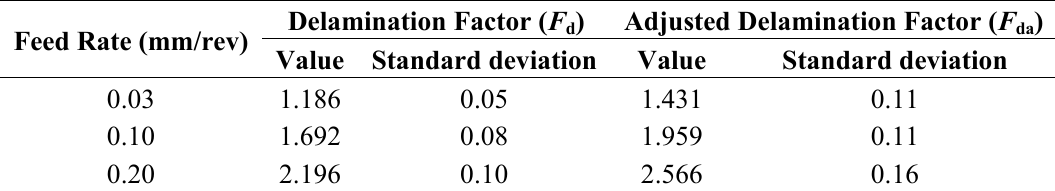
Table 1. Results of the delamination criteria for the three feed rates studied.